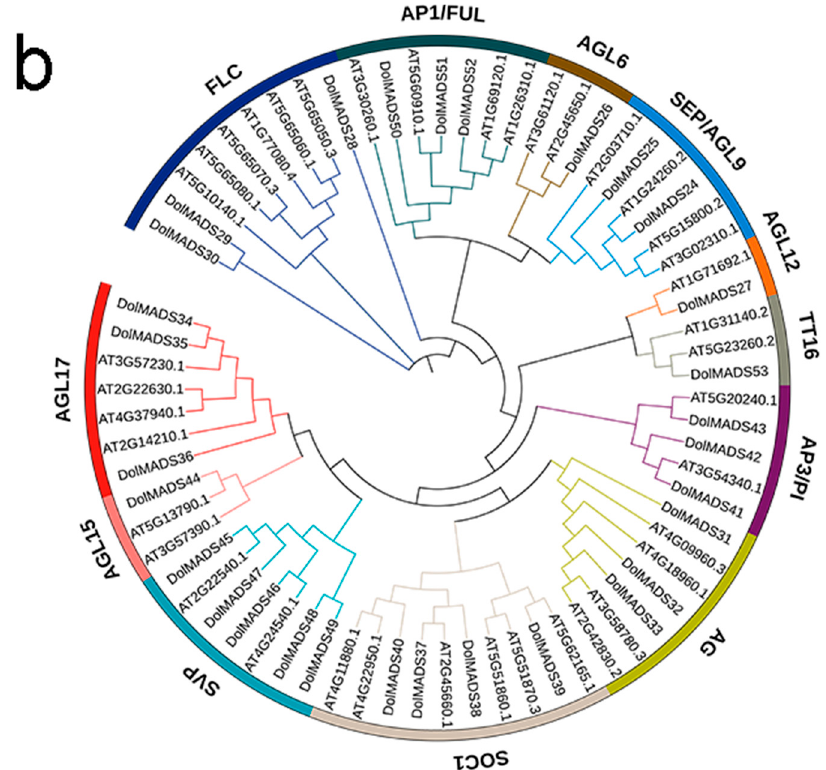
Figure 1. Phylogenetic trees of DolMADSs. ( a ) Type I MADS-box genes; ( b ) Type II MADS-box genes. The tree was visualized with the iTOL program. Different colours represent different groups.